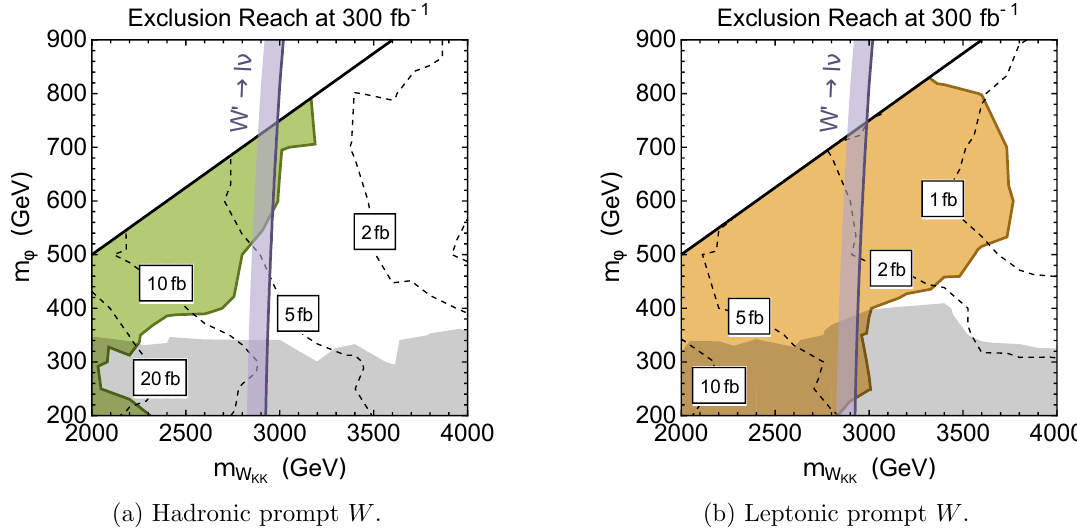
Figure 11. Projected exclusion reach with = 300 fb (cid:0) 1 for a fully hadronic boosted diboson jet L recoiling from a hadronic (green) or leptonic (orange) prompt W . The purple line indicates the current exclusion due to the search for W 0 ‘(cid:23) of ref. [33]. The dashed contours indicate the limit ! on (cid:27) ( W KK ) BR( W KK W’ ) BR( ’ WW ) obtained by the proposed search. In all cases, the (cid:2) ! (cid:2) ! tagger (intermediate or fully merged) with strongest sensitivity is used. The gray shaded regions below m ’ 350 GeV indicate the region where the fully merged tagger is the most ’